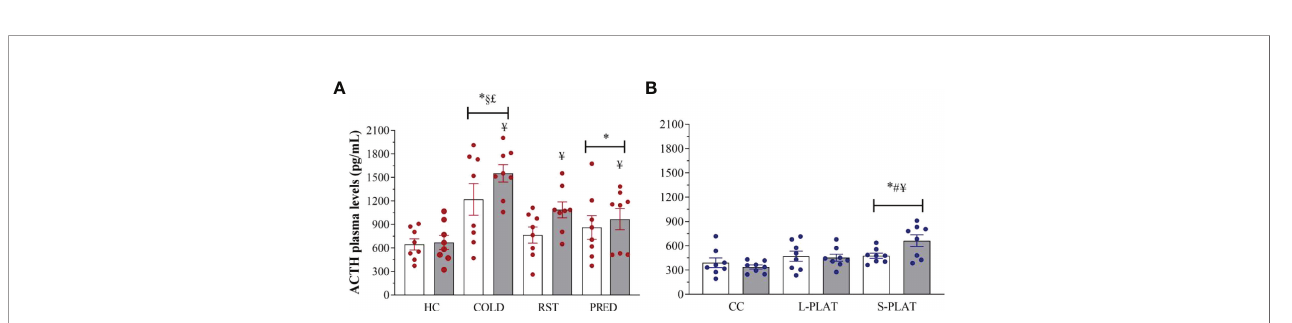
FIGURE 6 | (A) Effect of different stressors and (B) of PSD on ACTH plasma levels. Data were plotted with individual values and the columns represent the mean ± SEM of 8 animals/subgroup. HC, home cage; RST, restraint stress; PRED, predator odour; CC, container control; L-PLAT, large platform; S-PLAT, small platform. White columns represent single or 1-day exposure and grey columns, repeated or 4-day exposure. * = different from respective control group; § = different from RST group; £ = different from PRED group; # = different from L-PLAT group; ¥ - different from single or from 1-day